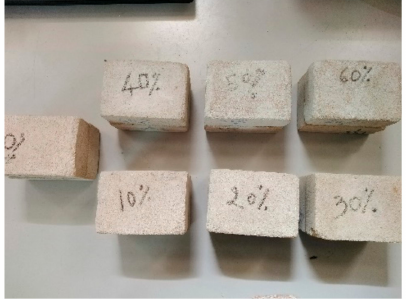
Figure 3. Control mortar samples, substituted at different ratios of glass powder.